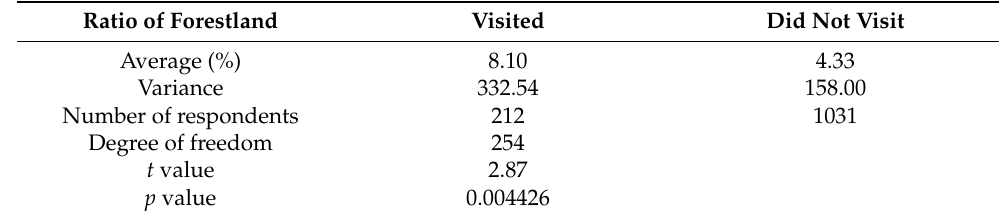
Table 1. Ratios of forestlands in the zip-code districts of respondents who visited/did not visit mountains in the emergency period. Ratio of Forestland Visited